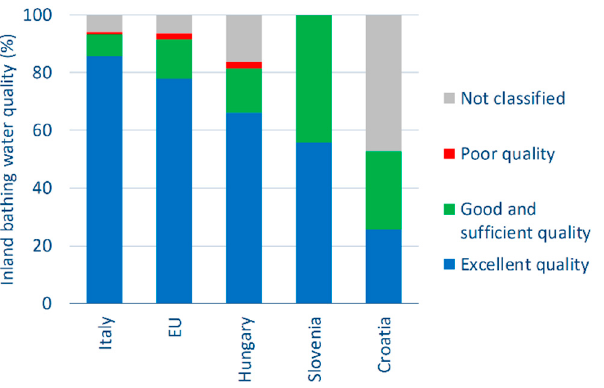
Figure 6. Ten-year average of inland bathing water quality in HR and neighboring EU Member